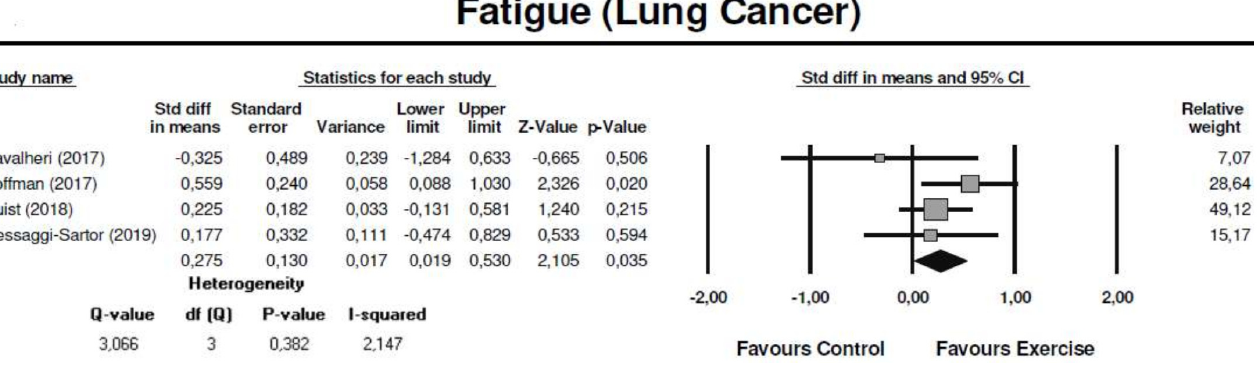
Figure 3. Meta-analysis for the effect estimate of exercise training in lung cancer patients: Fatigue symptoms.